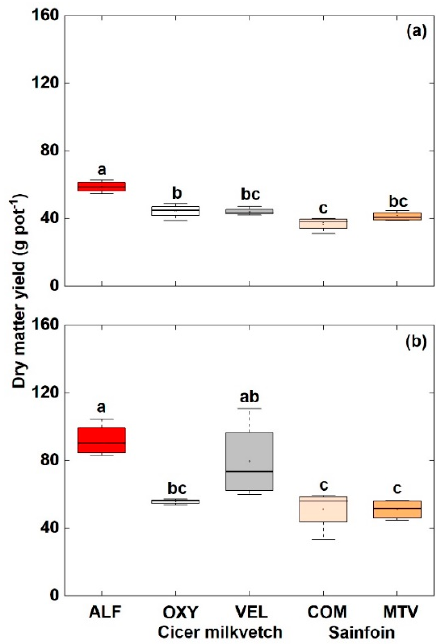
Figure 4. Shoot ( a ) and root dry matter yield ( b ) (g pot − 1 ) among legume species and cultivars ( n = 4) grown under controlled environment conditions. ALF = alfalfa, OXY = Oxley II milkvetch, VEL = Veldt milkvetch, COM = Common sainfoin, MTV = Mountainview sainfoin. The box is comprised of the 75th percentile, median, and 25th percentile, while the upper and lower whiskers are the maximum and minimum values, respectively. Boxes with the same letters indicate no significant differences among legume cultivars within a panel ( p > 0.05) according to Tukey’s HSD test.